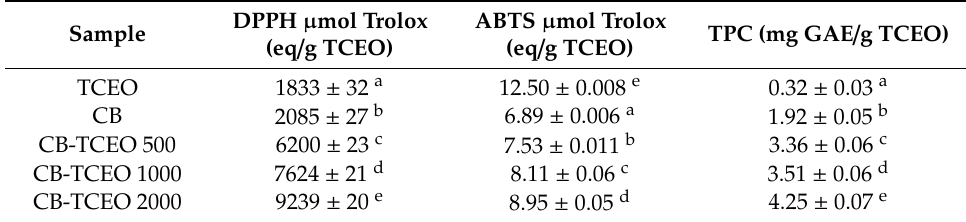
Table 1. Antioxidant activity of the TCEO, CB, and CB-TCEO samples.